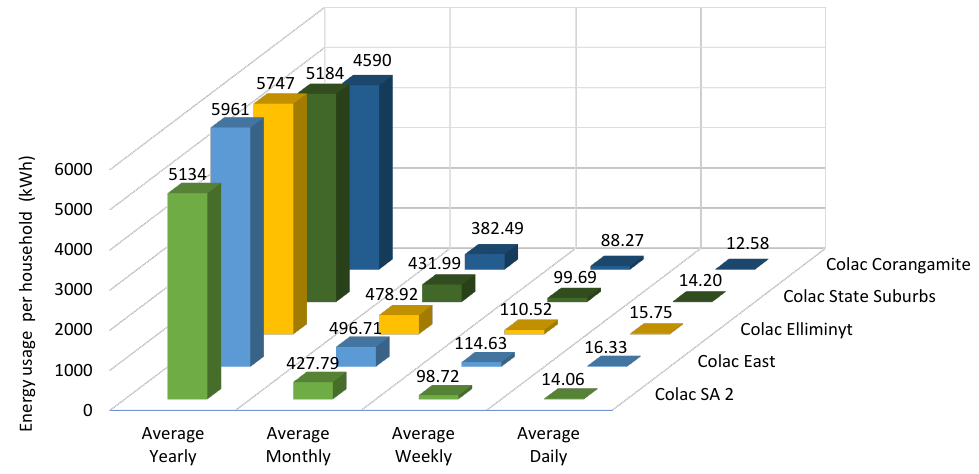
Figure 4. Daily, weekly, monthly, and yearly energy consumption at five demographic regions.